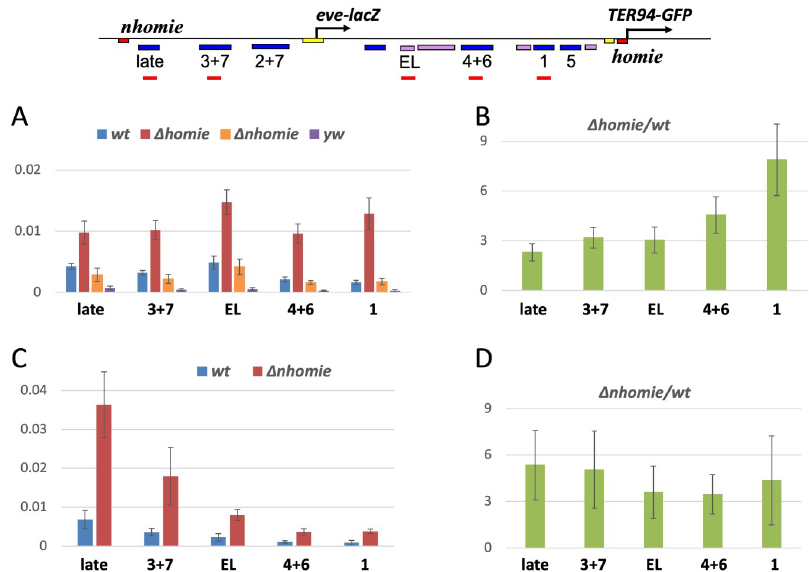
Fig 2. Non-coding RNA expression is increased by eve insulator removal. Top map : locations of amplification products quantified by qPCR are shown as red bars. (A, B) transgenes in the H5 orientation (see Fig 1A and 1B). (A) RT-qPCR quantification of total RNA (normalized to RP49 RNA) from the indicated enhancer regions, in the wt, Δ homie , and Δ nhomie transgenic lines (shown in Fig 1B), and in a yw control (no transgene: signal comes only from endogenous eve ). Averages with standard deviations of 3 biological samples are graphed. Note that transcript levels are increased throughout the locus in Δ homie , but not in Δ nhomie . (B) The ratios of average signals from Δ homie and wt in A are graphed (with standard deviations). (C, D) transgenes in the N5 orientation (see Fig 1A and 1C). (C) Similar to A, except that wt and Δ nhomie are at the insertion site shown in Fig 1C. (D) The ratios of average signals (with standard deviations) from Δ nhomie and wt in C are